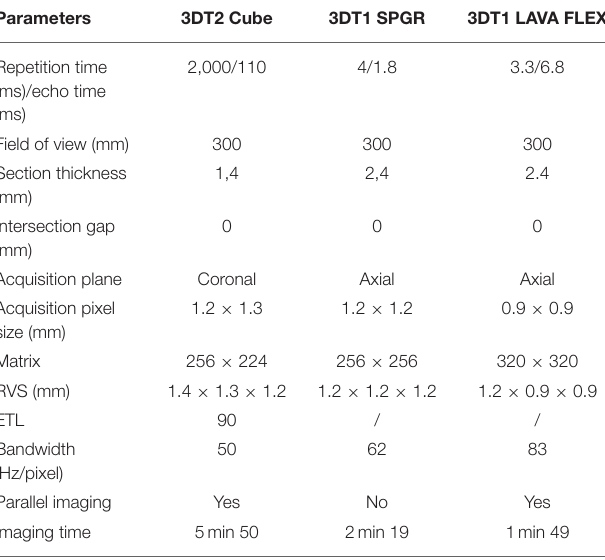
TABLE 1 | Parameters for 3DT2 and 3T1-weighted MR images with